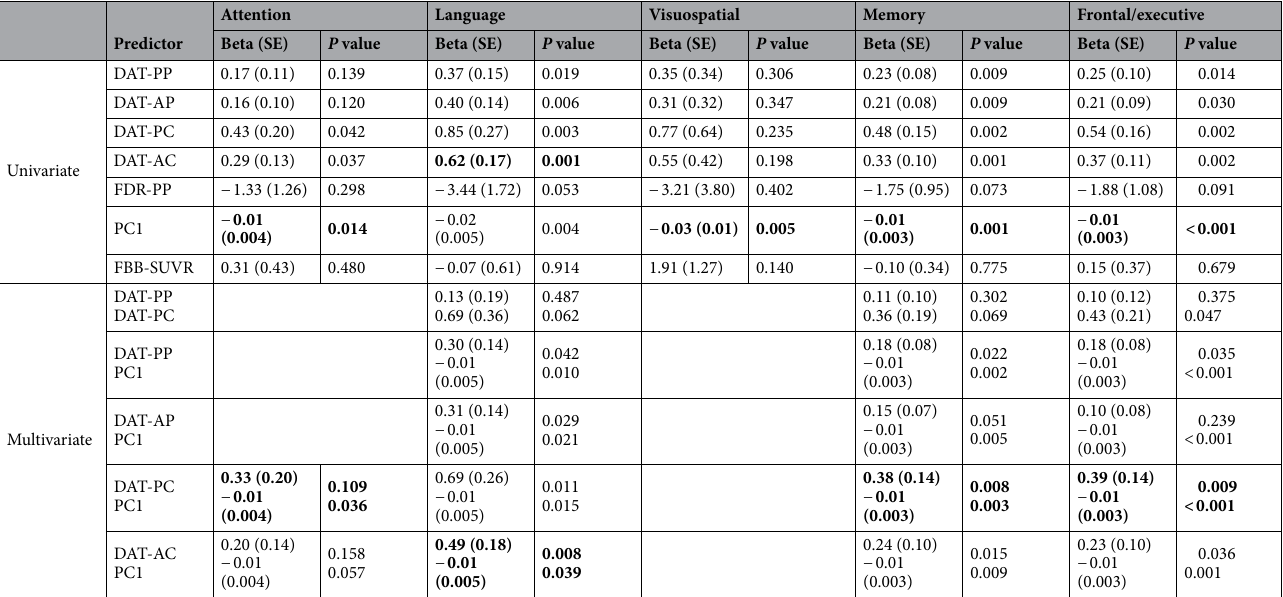
Table 5. Predictors for neuropsychological test scores in DLB patients. Results are based on general linear models for neuropsychological z scores after controlling for age, sex, education, HTN, DM, DWMH,